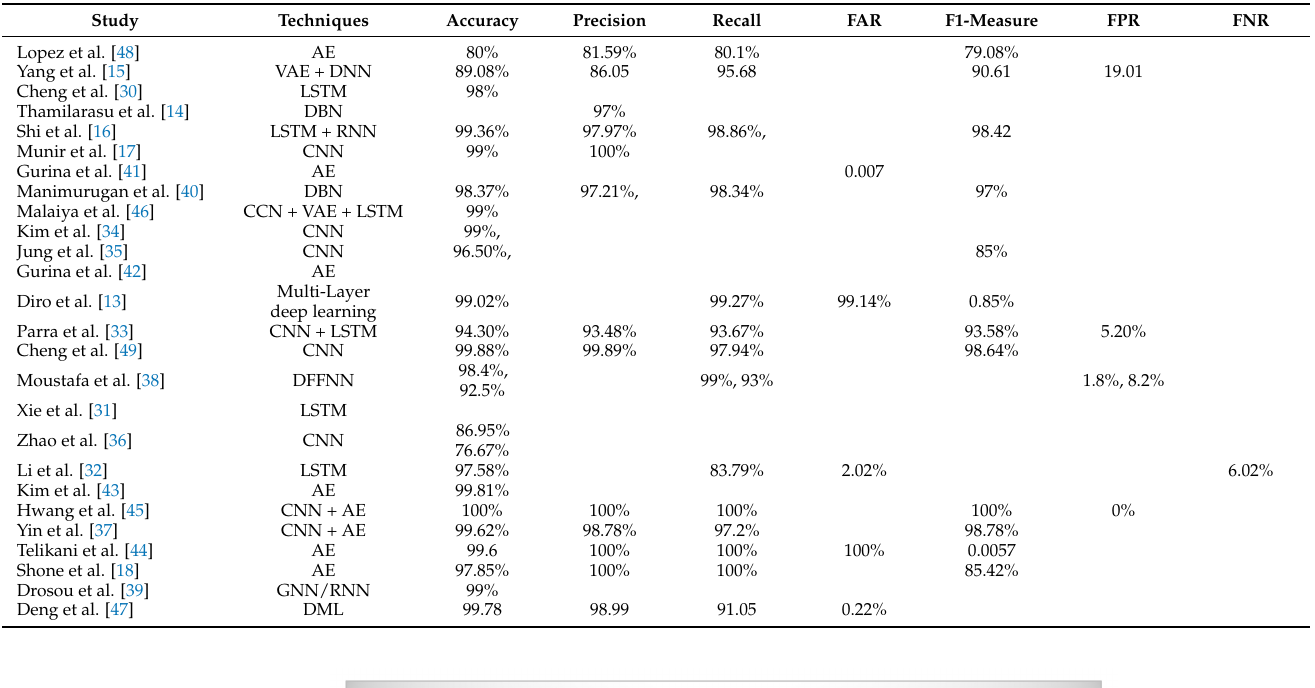
Table 3. Performance of the studies models.